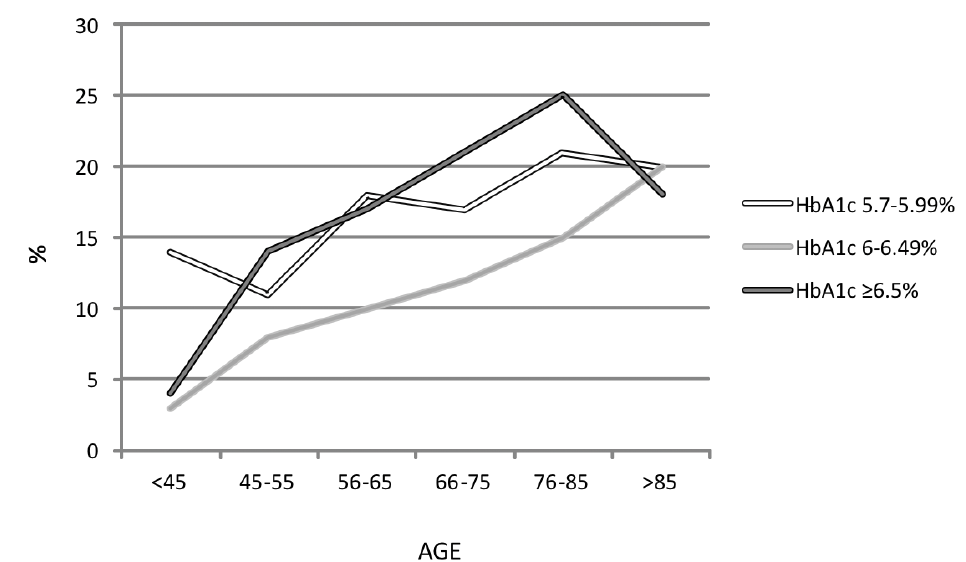
Figure 2. Interval age-specific prevalence of diabetes and prediabetes.